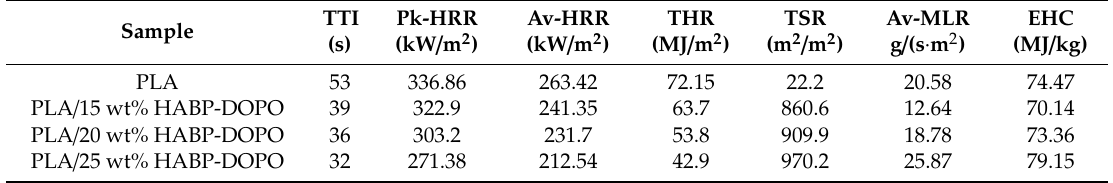
Figure 4. Total heat release (THR) curves of PLA and PLA / HABP-DOPO blends. Table 4. Cone calorimetric test data for PLA / HABP-DOPO blends.